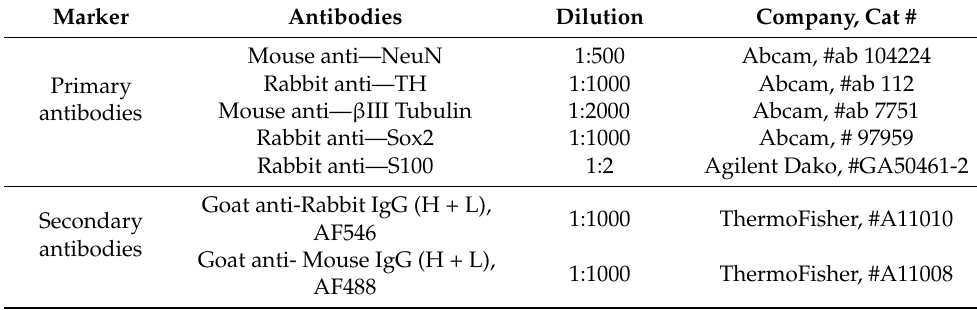
Table 8. Antibodies used in the study.